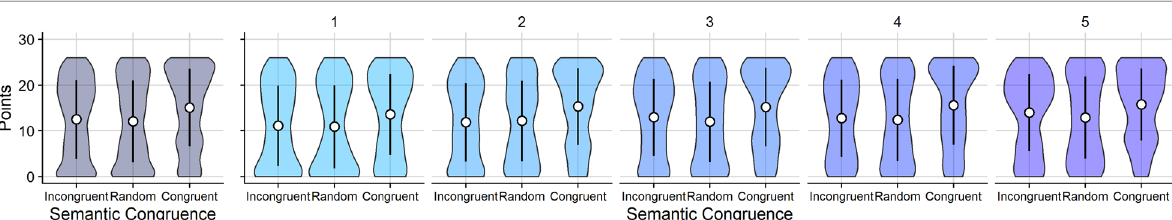
Fig. 12 Violin plots indicating points earned in each semantic congruence condition (left, N Incongruent = 1467, N Random = 1464, N Congruent = 1463), and additionally for each experimental session (right, each violin plot is based on between 269 and 300 observations). White circles represent the mean and error bars represent ± 1 standard deviation